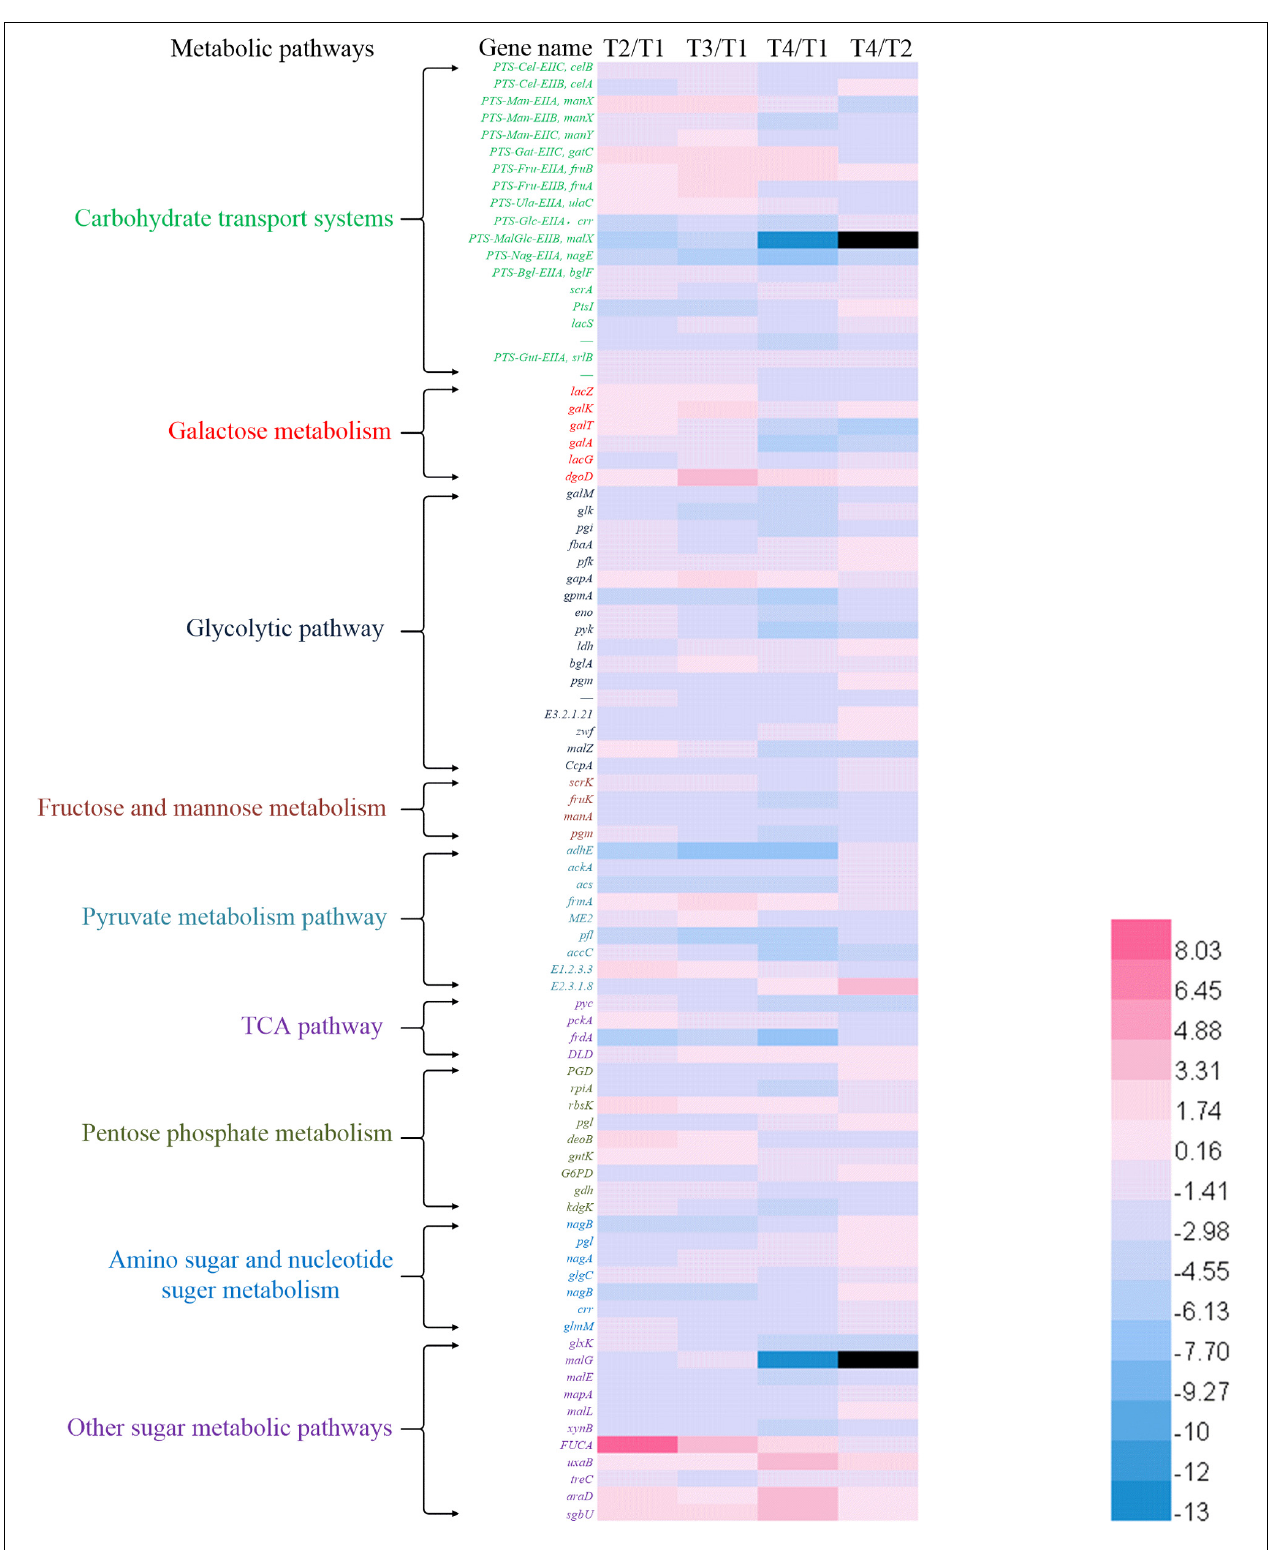
FIGURE 3 | Heat map of expression ratio values of the genes involved in metabolic pathways between different culture times.